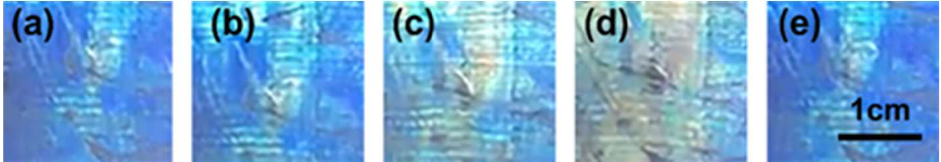
Figure 6. The structural color of the SF-PNIPAM dual-crosslinked nanocomposite film (1 mm) with different deformations ( a ) 0%; ( b ) 5%; ( c ) 10%; ( d ) 15%; ( e ) Remove external force.